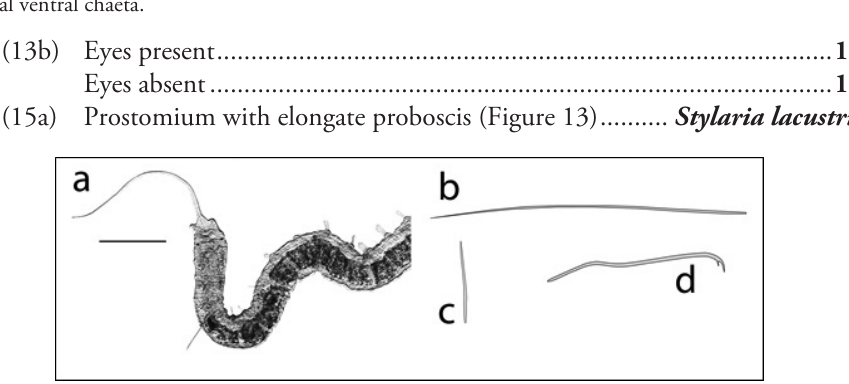
Figure 13. Stylaria lacustris , showing elongate prostomial proboscis, eyes, and typical chaetae: A photo of anterior end (scale 500 µm) B drawing of dorsal “hair” C drawing of dorsal “needle” D drawing of ventral chaeta.